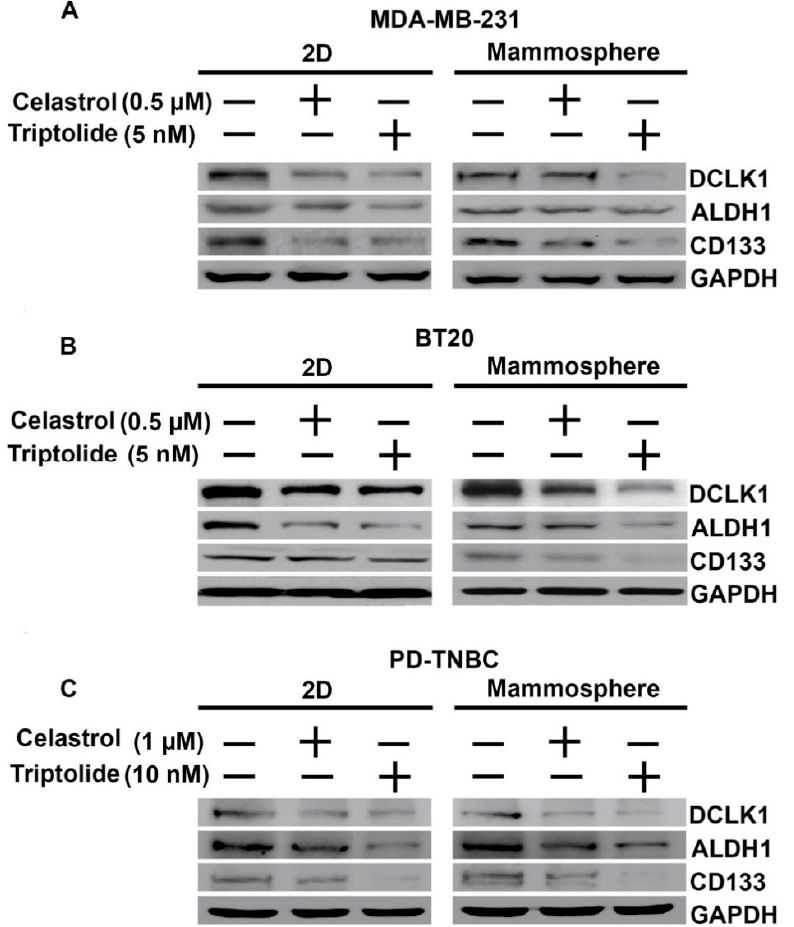
Figure 2. Celastrol and Triptolide attenuate expression of stem cell markers in TNBC cells. The two compounds inhibit cancer stem cells marker, DCLK1, ALDH1, and CD133 protein expression as compared to control, untreated cells in both 2D culture (left panel) and mammosphere cultures (right panel). ( A ) MDA-MB-231, ( B ) BT20, and ( C ) PD-TNBC.